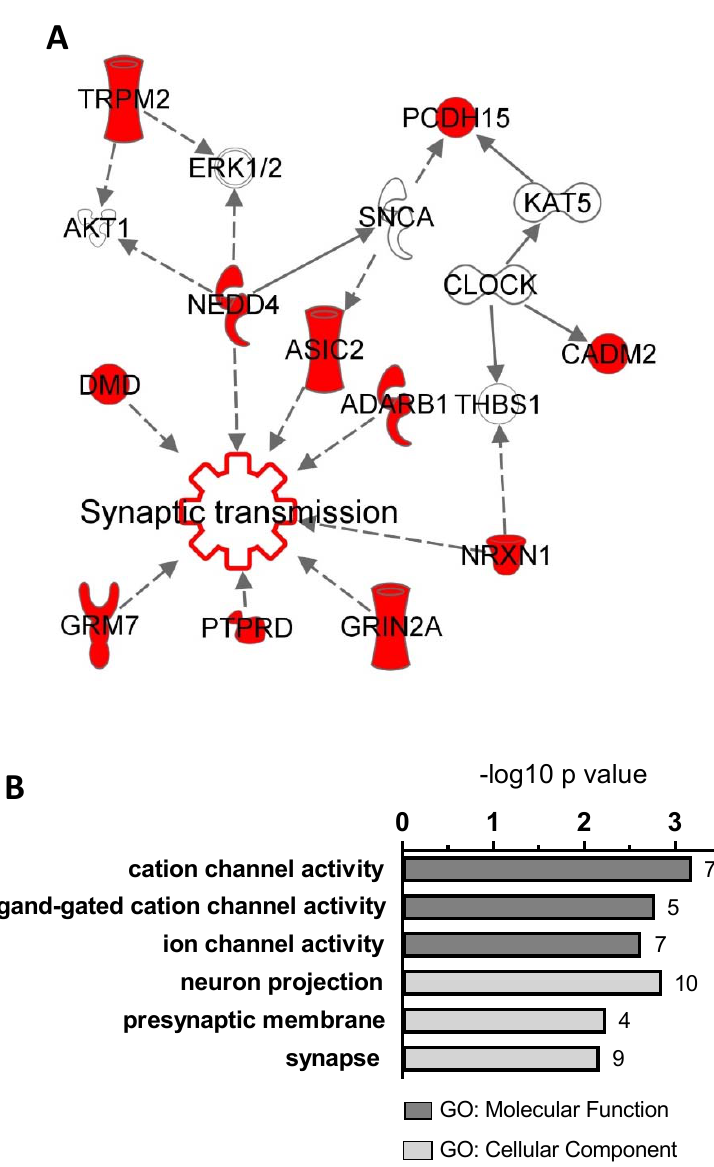
Figure 2. Bioinformatic analyses performed on ASD-candidate genes encompassed by C-CNVs. ( A ) A Core analysis run in Variant Effects Analysis mode using the Ingenuity Pathway Analysis software figured out cellular processes related to our gene dataset (21 genes) generating a functional network encompassing 11 genes (in red). Synaptic transmission resulted the most significant functional annotation ( p -value 6.05 × 10 − 9 ). Bridging nodes (in white) were denoted evaluating both direct and indirect interactions related only to neurological diseases and with stringent level of confidence ( B ). Gene ontology (GO) categorization was carried out using ToppGene Suite. Top three ontologies for Molecular Function (dark grey) and Cellular Component (light grey) were annotated; statistical significance of GO terms was reported as − log10 ( p- value). The number of genes belonging to each category was reported on the right of each bar.